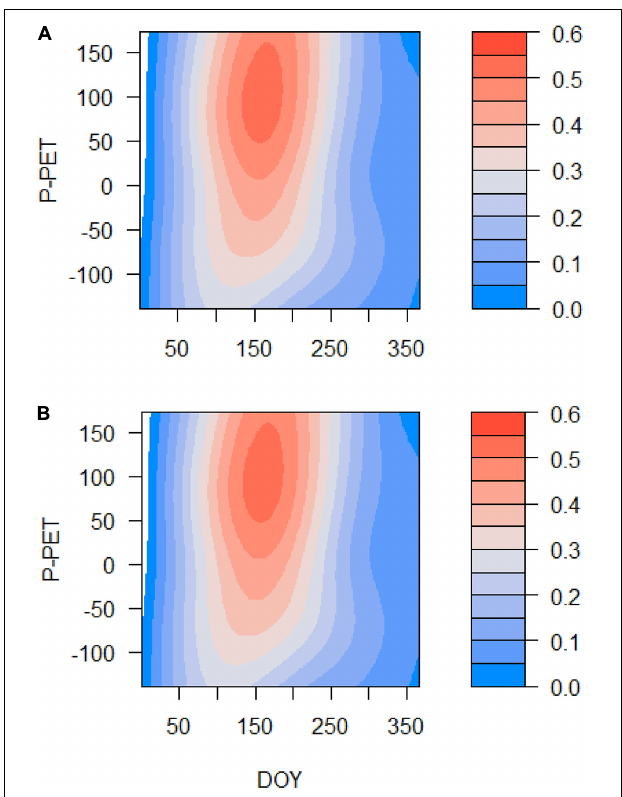
FIGURE 7 | Effects of the DOY, the spring water balance (P – PET, Y -axis), and their interaction on the simulated Gr (color scale) in the Orera (A) and Miedes (B) study sites. The analyses correspond to GAMMs fitted to Gr data for the period